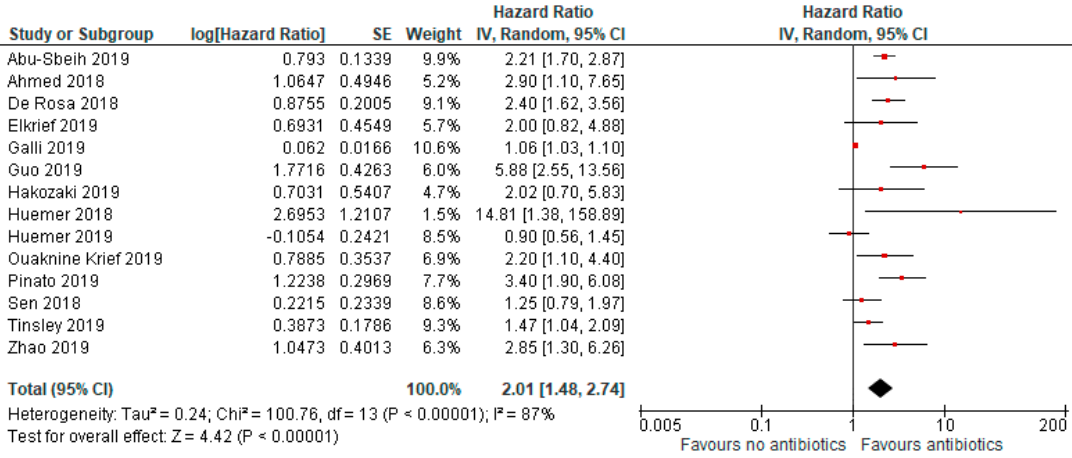
Figure 2. Forrest plot for progression-free survival in patients assuming antibiotics pre/during immunotherapy. IV, inverse variance; CI, confidence interval; SE, standard error.